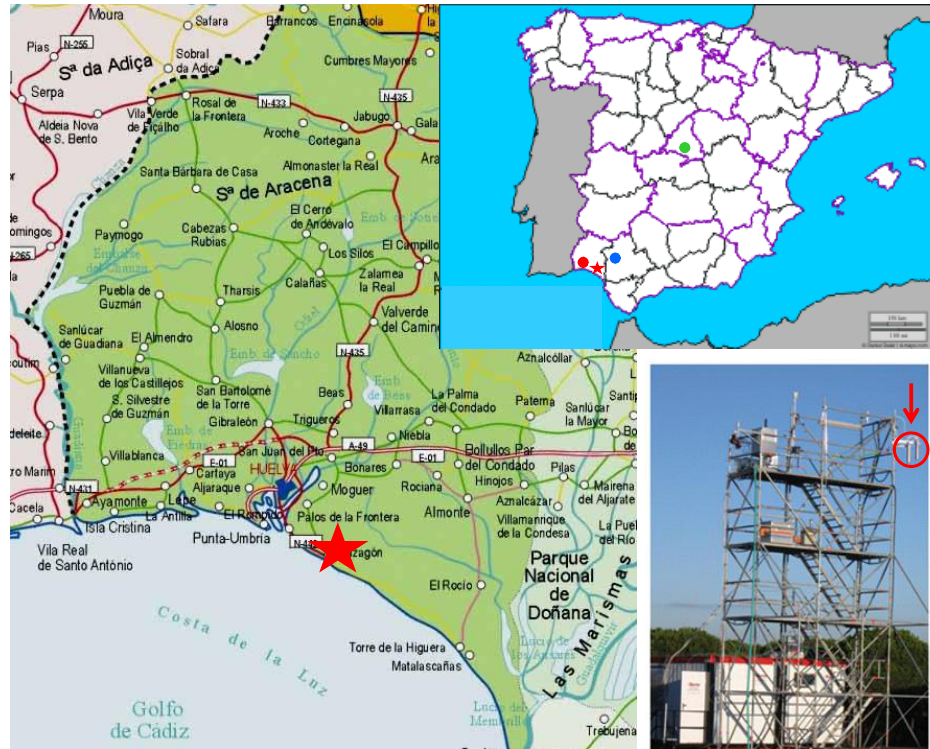
Fig. 1. Map of the site. El Arenosillo is highlighted by a red star. Main urban locations in the prevailing wind directions are also marked by dots: Huelva (red), Sevilla (blue) and Madrid (green). On the right side of the picture an arrow indicates the position of the DUALER inlet on the top of the 10m scaffold for DOMINO